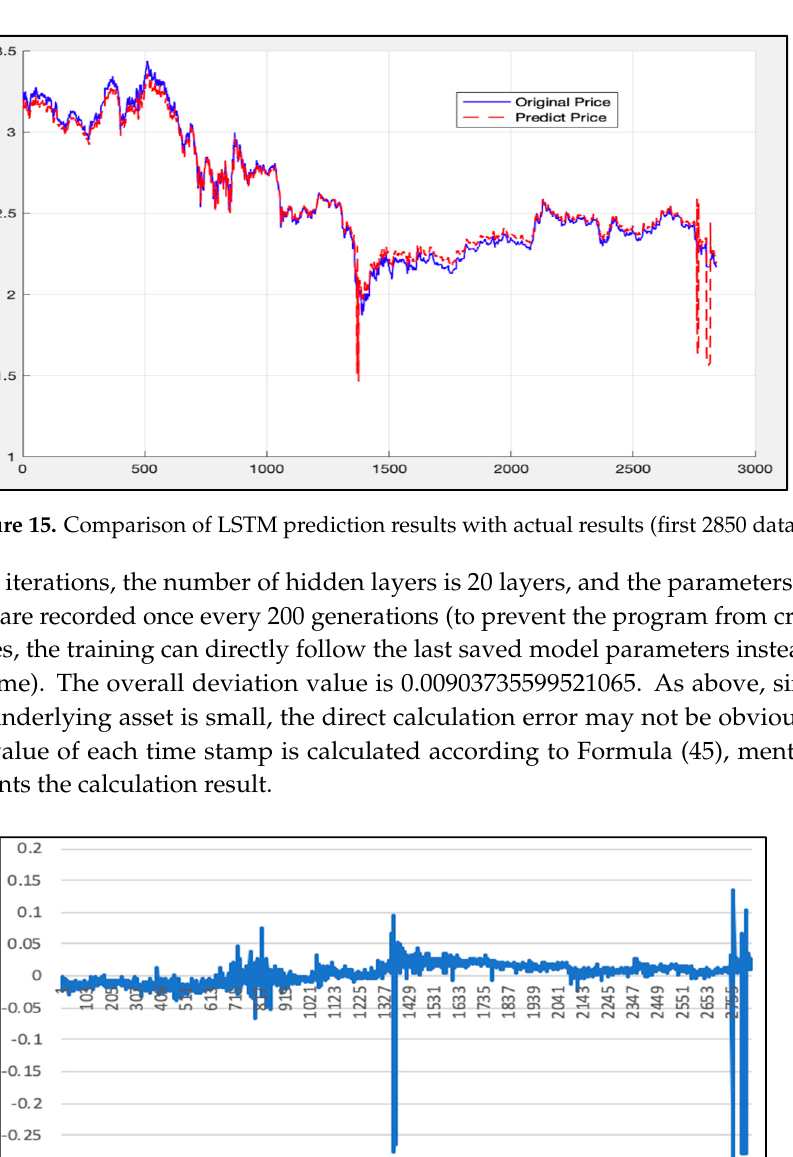
Algorithms 2019 , 12 , x FOR PEER REVIEW